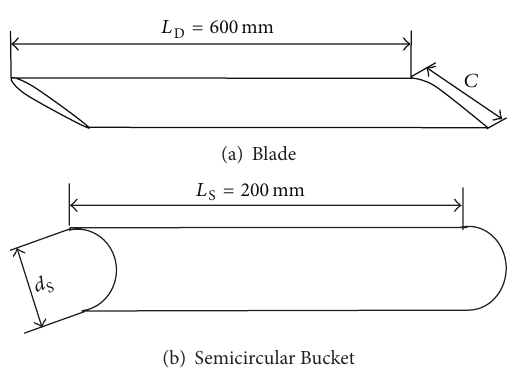
Figure 1: Darrieus-Savonius rotor.